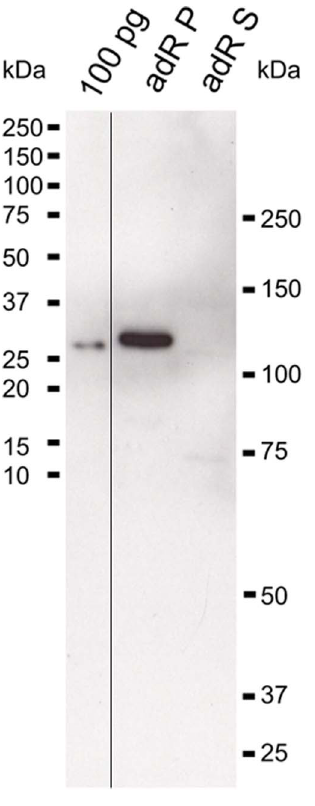
Figure 1. Specificity of anti-zGC3 antibody. Hundred pg of the antigen, the pellet adRP) and soluble fraction (adRS) of 1/10 of an adult zebrafish retina each were probed with the purified polyclonal anti- zGC3 antibody (1:1000); secondary antibody was a goat anti rabbit coupled to peroxidase (1:5000).